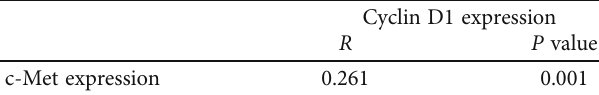
Table 5: Correlation between c-Met and cyclin